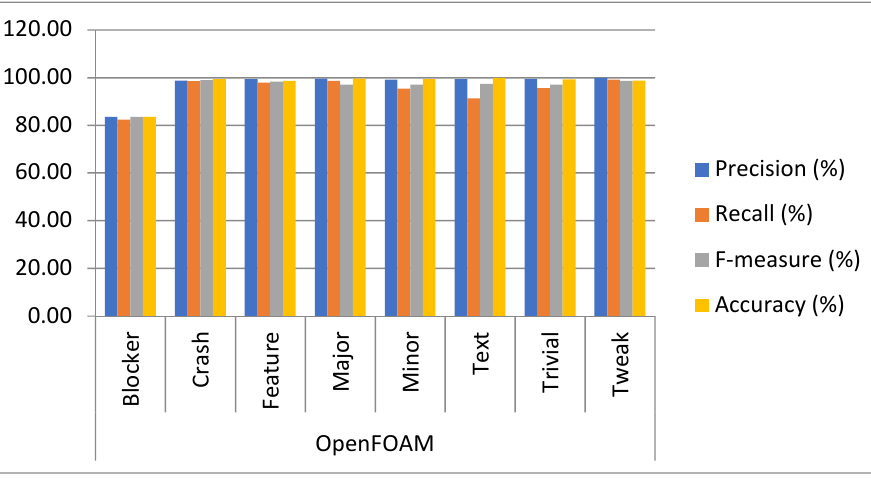
Figure 10. Comparison of the proposed BCR on all classes and datasets . RQ2. Does the proposed algorithm outperform the traditional machine learning algorithms in bug severity classification? Approach: The proposed deep learning model is compared with the existing machine learning model [26] based on bug severity classification. Zhou et al. proposed a hybrid approach by combining text and data mining models. They applied the Multinomial Naive Bayes (MNB) algorithm for binary severity classification. They classified the bugs into either bug or non-bug. Further, the authors validated the proposed approach on five open source projects, as shown in Table 1. To compare the efficiency of the proposed BCR model, the average F-measure of the binary classes (bug or non-bug) was computed on the same dataset as used by Zhou et al. Finding: The comparison is shown in Table 5 and Figure 11. Zhou et al. have shown the average F-measure of binary classes is in the range of 79% to 94% for all five projects. It can be seen that the average F-measure of the BCR of the binary class is between 91% to 99%, and this highlights the ability of the extensive features extracted by the FECNN model. It is also clearly apparent that BCR significantly outperforms the existing machine-learning-based bug severity classification model. The total average F-measure of BCR reaches 96.43% for five projects, which is roughly 13% higher than the average F-measure of the existing machine learning bug severity classification model. This is because the CNN model automatically detected the highly complicated and important non-linear features in some initial hidden layers, whereas the shallow machine learning algorithms used the